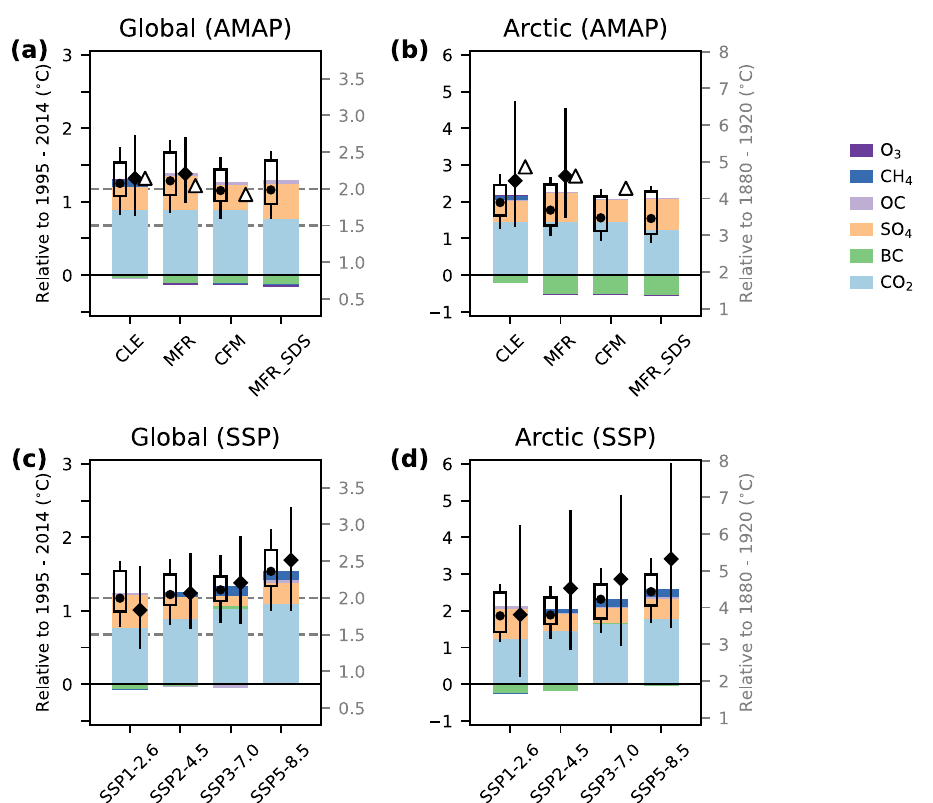
Fig. 2 Projected global and Arctic mean temperature changes in 2050. a , b are for Arctic Monitoring and Assessment Programme (AMAP) air pollution mitigation scenarios and c , d for Shared Socioeconomic Pathways (SSP) climate scenarios. Black diamonds refer to the multi-model median temperatures in Earth System Models (ESMs) for 2046 – 2055, relative to 1995 – 2014 (black font), where available. Warming relative to preindustrial conditions is also indicated (grey font, with 1.5 and 2 °C thresholds indicated by dashed lines in a , c ). Color bars refer to the contributions from the individual changes in air pollutant and greenhouse gas emissions to forced temperature changes, based on emulator simulations (legend). Black bullets refer to the corresponding net changes. Results from the MRI-ESM2 are shown, the only ESM that ran the CFM scenario (triangles in a , b ). Contributions from tropospheric ozone (O 3 , less than 0.03 °C) and OC (less than 0.09 °C) are barely discernible but are included for the sake of completeness (AMAP scenarios only). 5 – 95% con fi dence intervals ( ± 1.64 σ ), resulting from uncertainties in all simulated processes, are indicated by black vertical lines (error bars). Con fi dence ranges due to radiative forcing uncertainty in the emulator are indicated by transparent rectangles. The emulator does not account for unforced natural variability and so con fi dence ranges are typically smaller than ESM con fi dence ranges. See the Supplementary Note 4 for simulation details and Supplementary Fig. 9 for results for